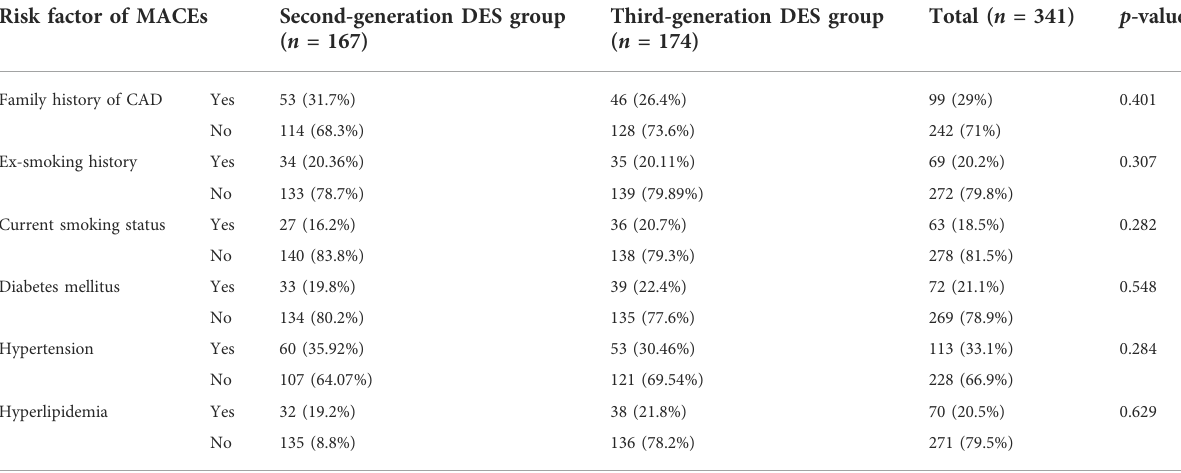
TABLE 3 Risk factors in the study participants.